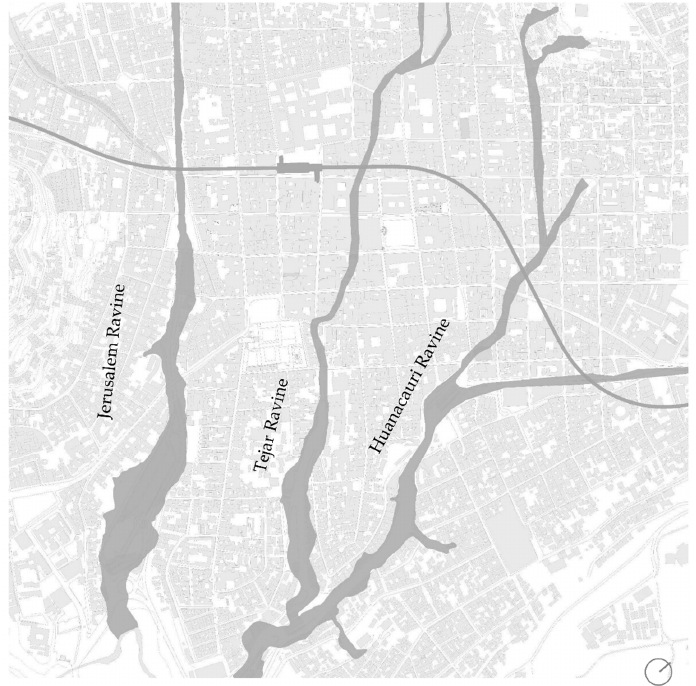
Figure 2. Map of the most exposed area with the hypothetical course of the ravines. Scale: